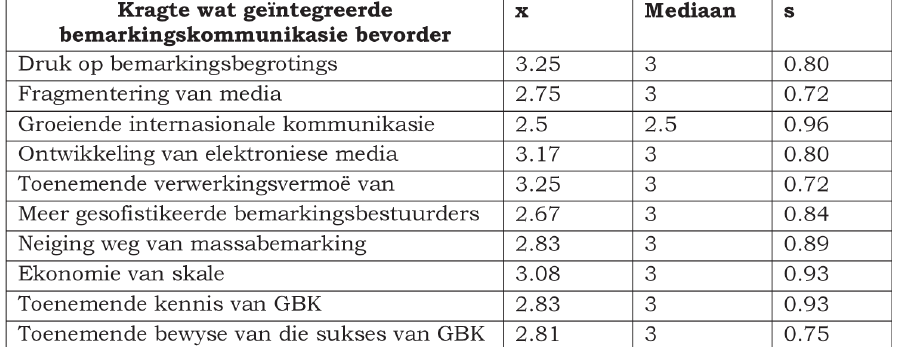
TABEL 3: Kragte wat geïntegreerde bemarkingskommunikasie bevorder